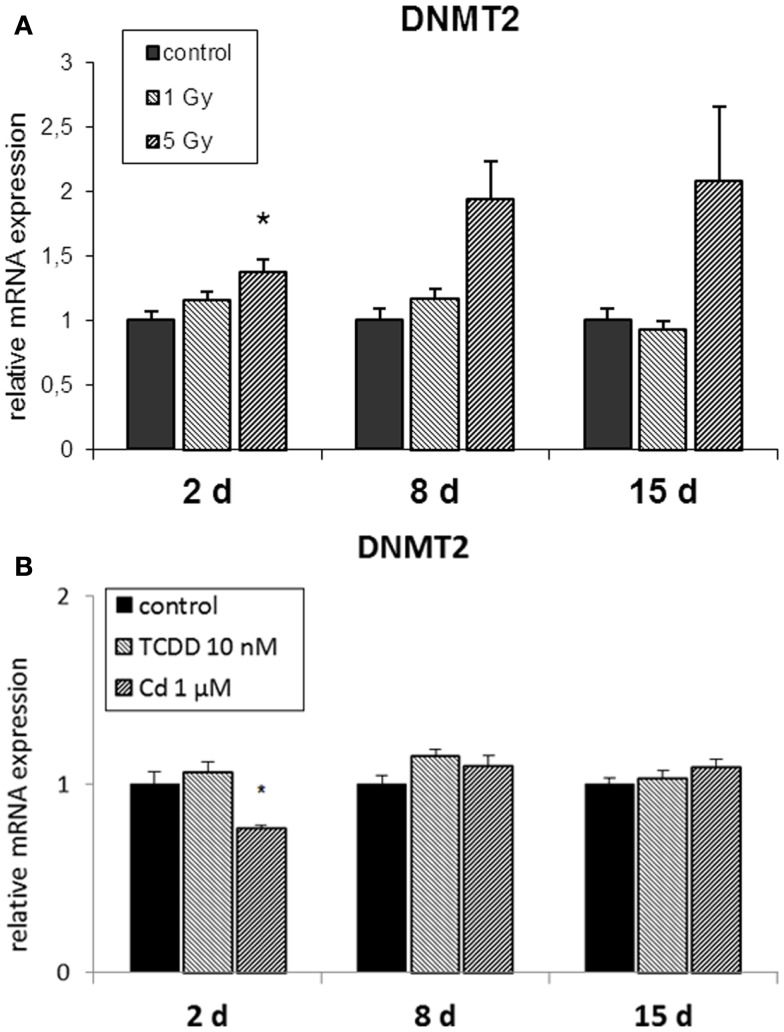
Direct (2 days) or delayed (8 and 15 days) mRNA expression of DNMT2 after 2 days of exposure to (A) 10 nM TCDD or 1 μM cadmium (n = 3) and (B) single dose of 1 or 5 Gy ionizing radiation (n = 5 or 3). An asterisk (*) represents a p-value <0.05.